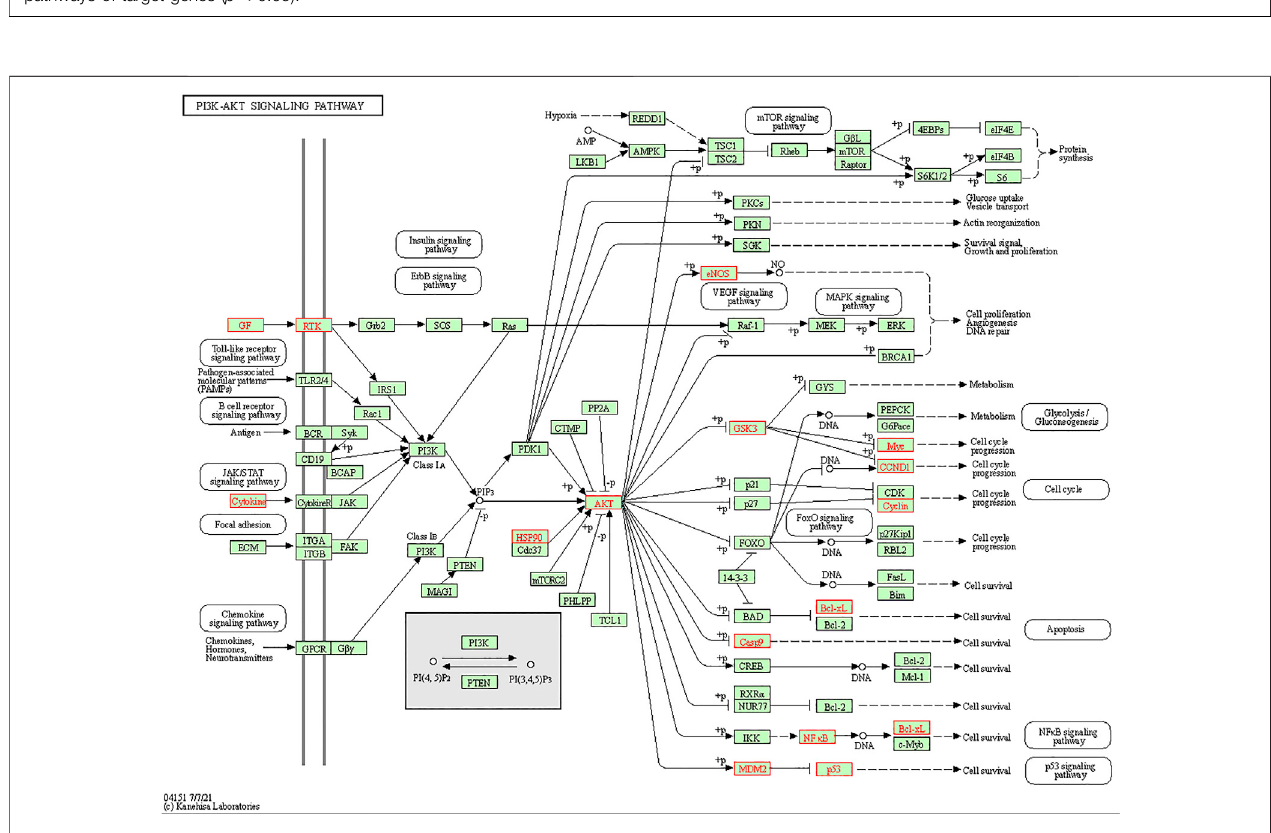
FIGURE 6 | Screening of PI3K/AKT signaling pathway in apoptosis. The red marked nodes represent overlapping targets of colchicine and MIRI.